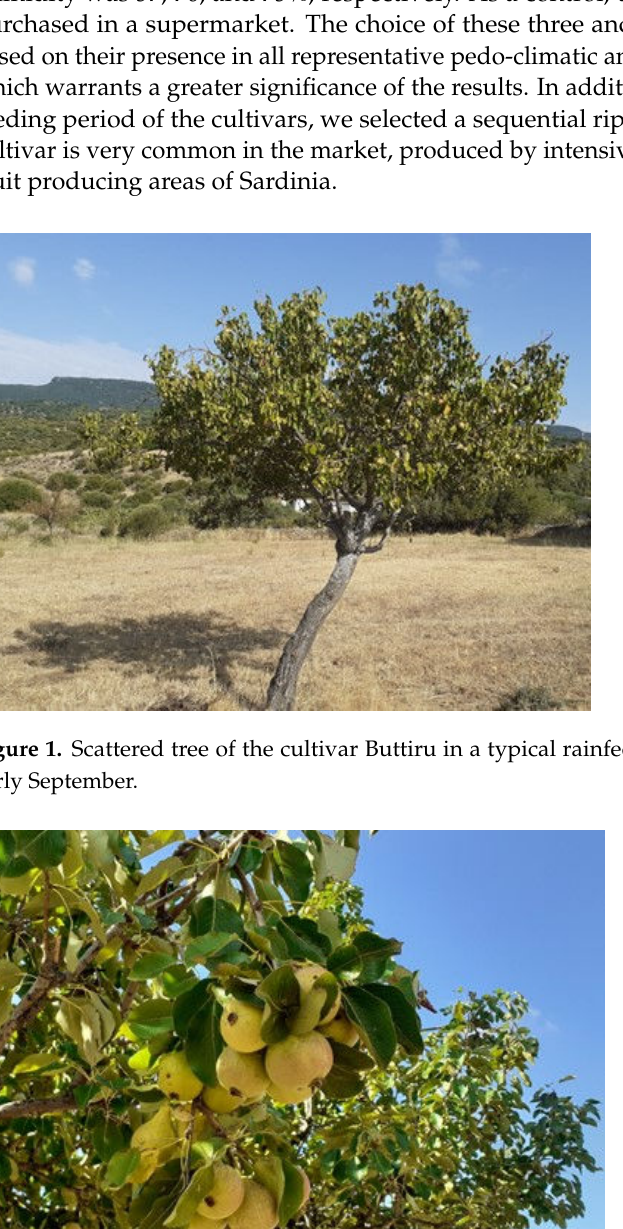
Figure 2. Details of the fruits of Camusina cultivar to be harvested in early August.